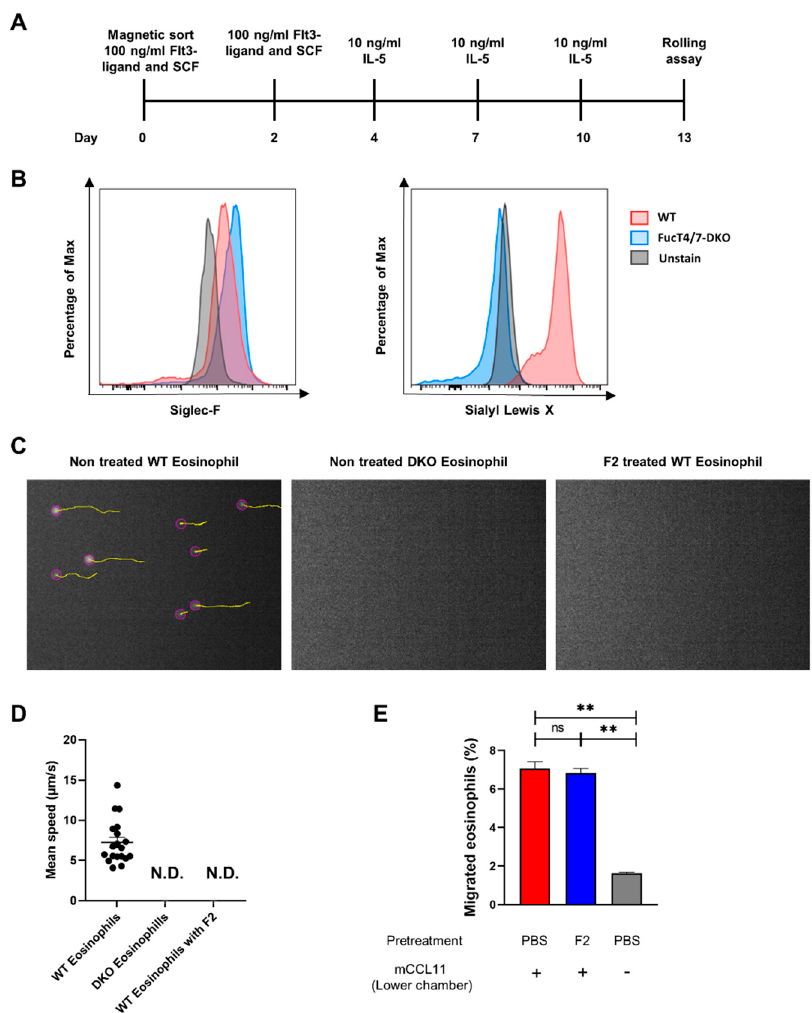
Figure 6. SLex mediated rolling of eosinophils on P-selectin-expressing cells without affecting the migration. ( A ) The schedule of eosinophil induction. The mouse hematopoietic progenitor cells were isolated from the bone marrow using the Mojosort TM hematopoietic progenitor cell isolation kit. FLT3-Ligand and SCF were added to the culture medium on days 0 and 2. The medium was partly exchanged with medium supplemented with IL-5 on days 4, 7, and 10. ( B ) The harvested eosinophils were analyzed using flow cytometry. The mature eosinophils were defined as CD45 + Siglec-F + CD11b + CCR3 High . The experiment was independently repeated twice. ( C ) The rolling assays were performed, and the videos were taken using a CMOS camera equipped on a microscope at the speed of 20 photos per second for 30 s. In total, the stuck of 600 pictures were analyzed using Trackmate in Fiji ImageJ after subtracting the background. The rolling cells are circled with purple, and their rolling tracks are drawn in yellow by the software. The experiments were repeated twice independently. ( D ) The speed of the rolling cells was calculated using the Trackmate in Fiji ImageJ. In the WT eosinophil group, most of the cells moved between 5 and 15 μ m/s. No rolling cells were detected in the DKO eosinophil (DKO Eosinophils) and F2-treated WT eosinophil groups (WT Eosinophils with F2). ( E ) A migration assay was performed using transwells, and the percentage of migrated eosinophils into the lower chamber was shown. Cells from the murine bone marrow was pretreated with or without F2 mAb and used for the migration assay. The lower chamber contained mCCL11 or medium only. ** p < 0.01. A p -value of less than 0.05 was considered significant.